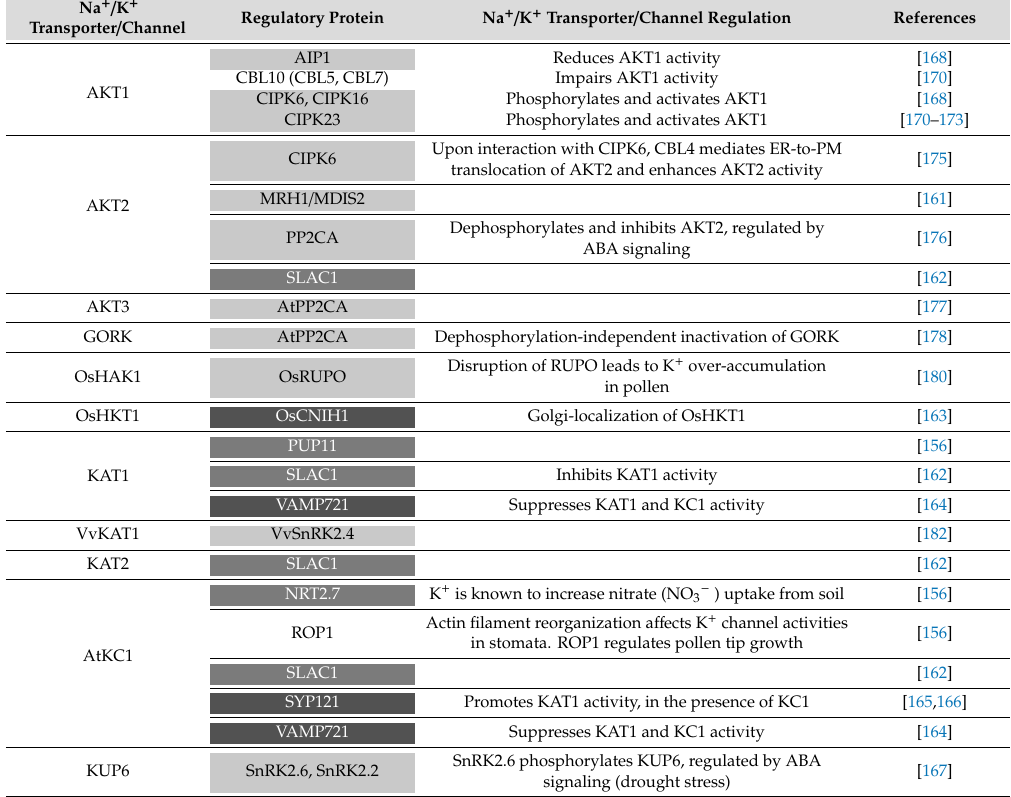
Table5. RegulatoryproteinsofK + / Na + transporters / channelsdetectedusingprotein–proteininteraction techniques in yeast. Light gray, kinases and phosphatases; medium gray, channels and transporters; dark gray targeting-related